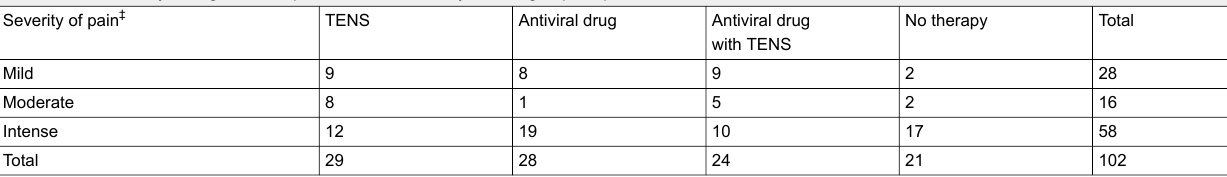
Table 2: Pain severity during acute herpes zoster in differently treated groups of patients. Severity of pain ‡